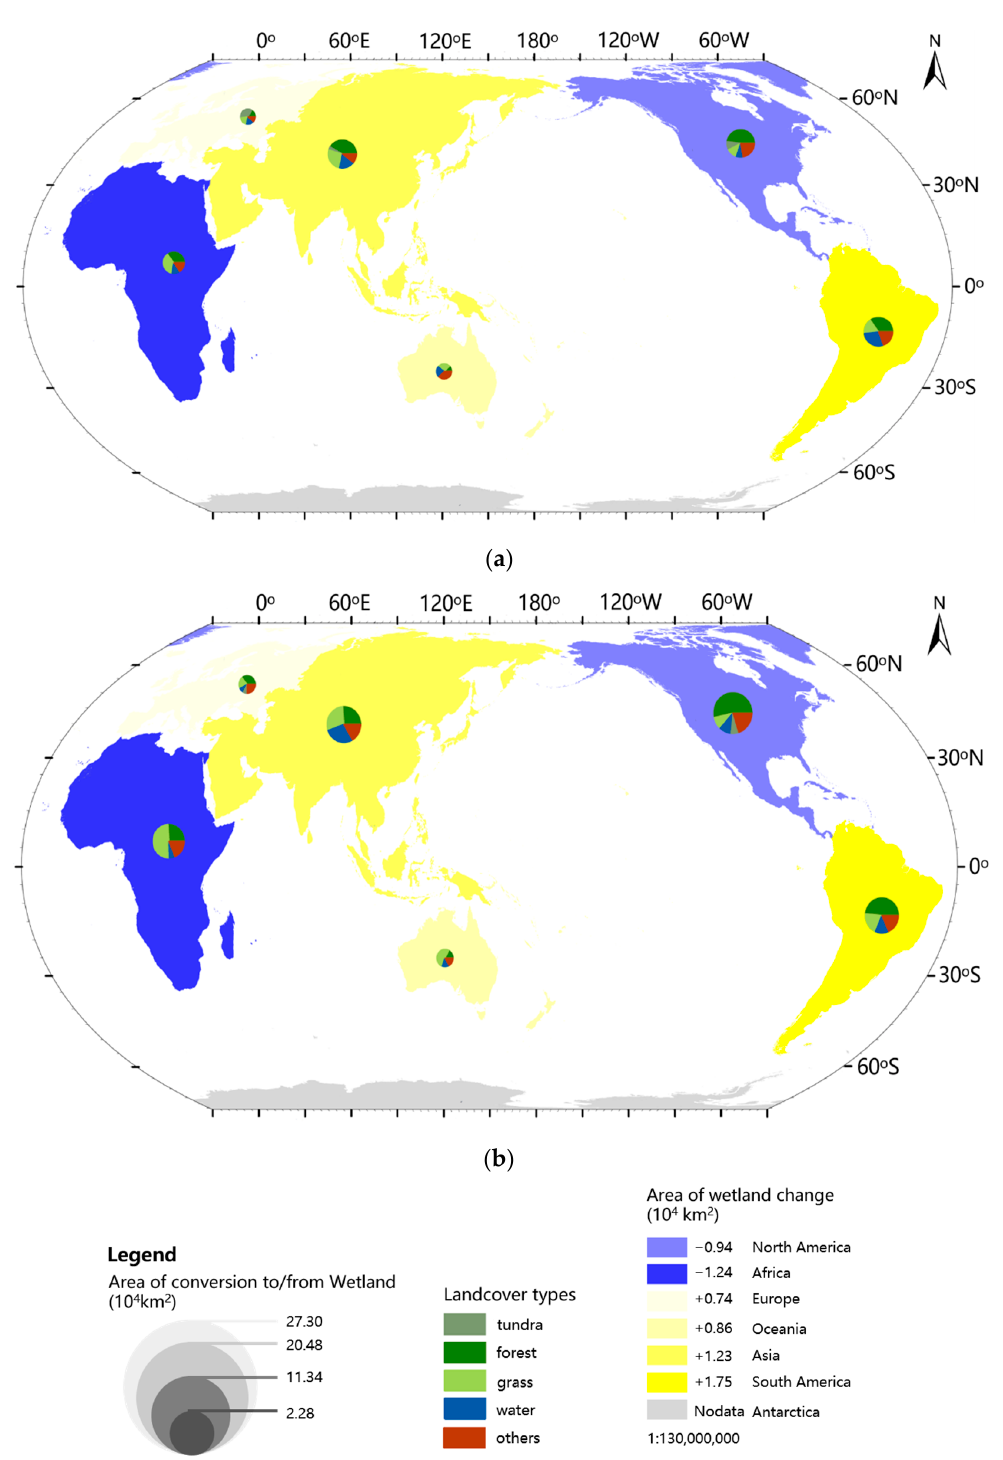
Figure 8. Wetlands conversions with other land cover types by continent, 2000–2010. ( a ). Wetlands converted from other land cover types by continent, 2000–2010. ( b ). Wetlands converted to other land cover types by continent, 2000–2010.